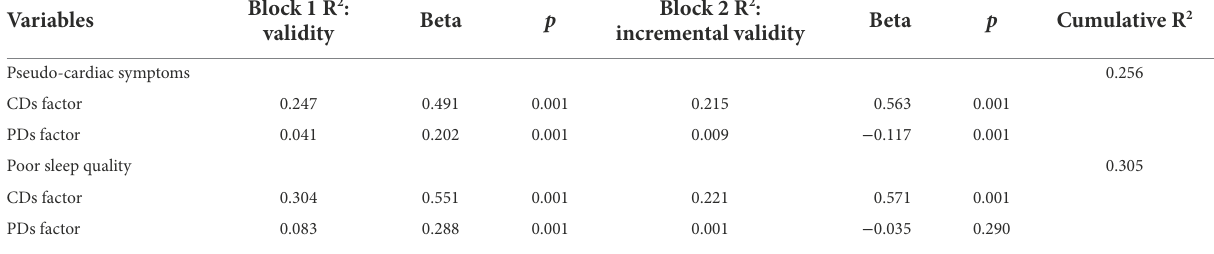
TABLE 3 The hierarchical regression models comparing PDs and CDs factors as blocks to predict pseudo-cardiac symptoms and poor sleep quality.